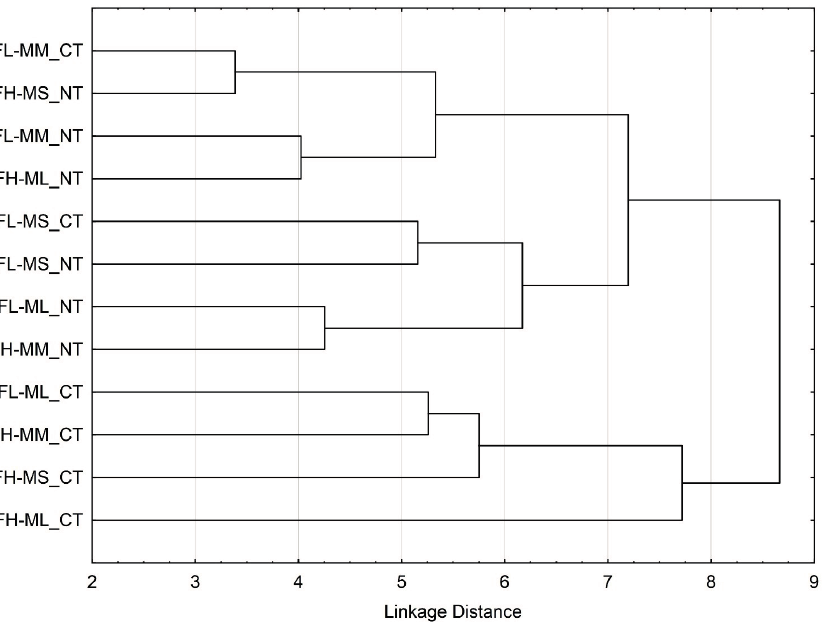
Figure 1. Cluster analyses illustrating the influence of fertilizer levels (FL = low fertilizer, FH = high fertilizer), cropping systems (MM = maize monoculture, MS = maize/soybean rotation, ML = maize/legume intercrop) and tillage (NT = no-till, CT = conventional tillage) on soil microbial functional